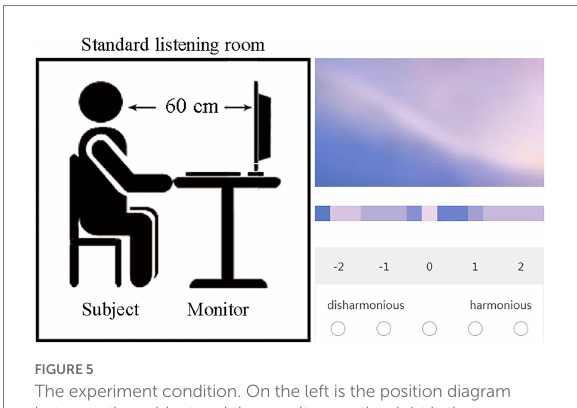
FIGURE 5 The experiment condition. On the left is the position diagram between the subject and the monitor; on the right is the operation interface for data collection by “wjx.cn” application on the mobile